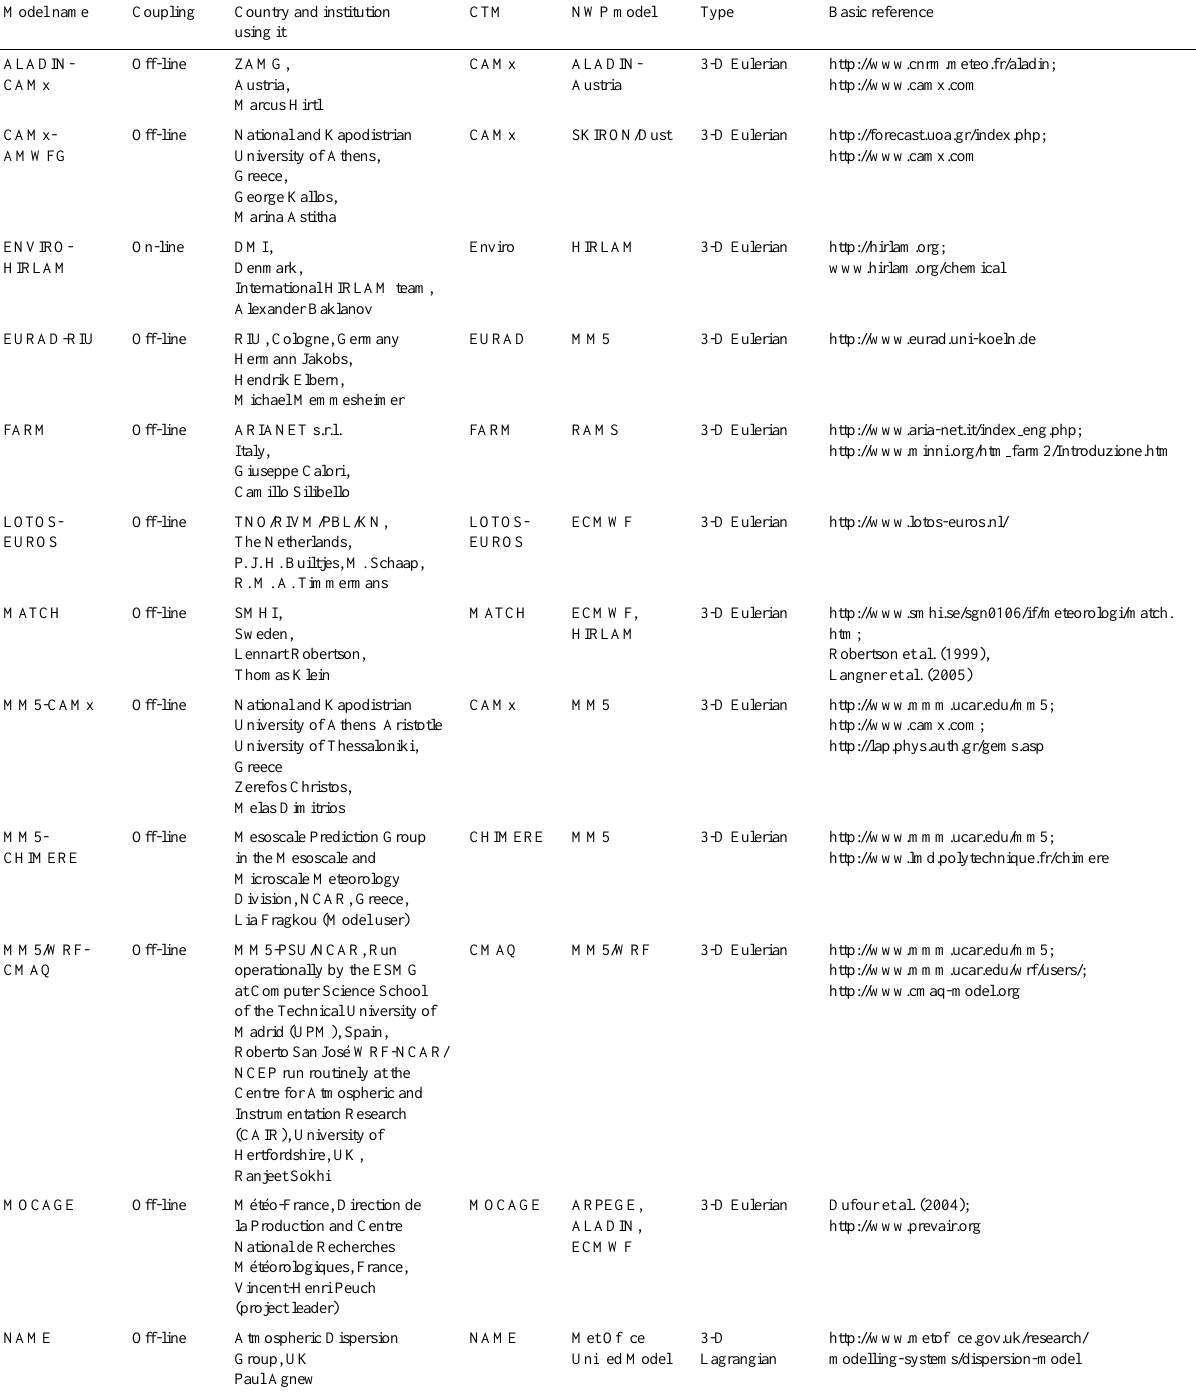
Table 1. Selected main characteristics of the 18 chemical weather forecasting (CWF) models considered in this study. Model